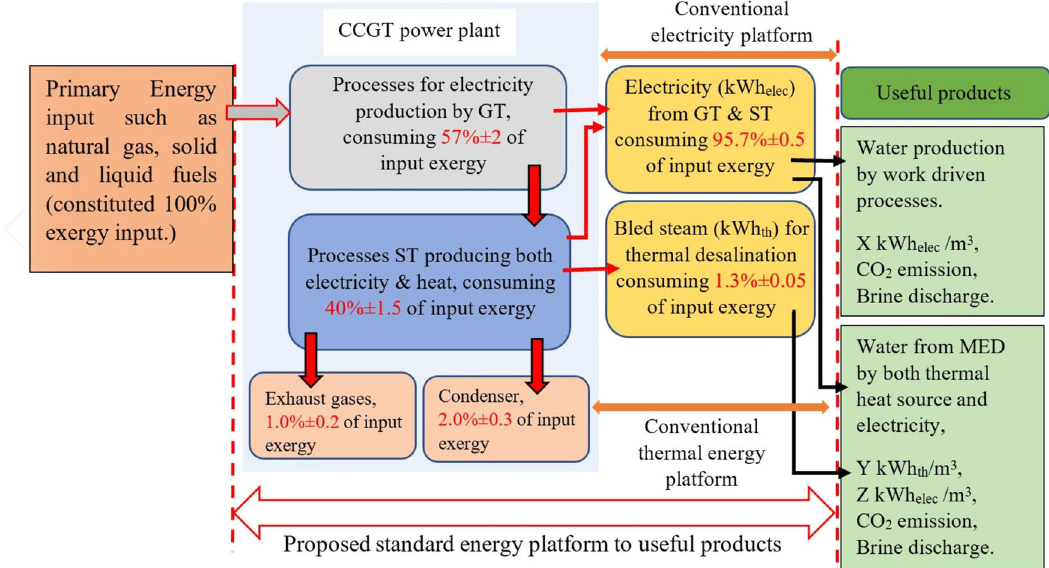
Fig. 2 Primary energy distribution in combined power and water plant. Primary energy distribution in combined power and water